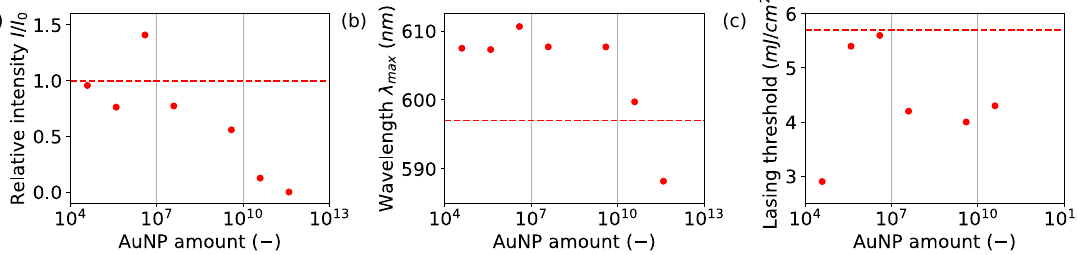
Figure 4. ( a ) relative maximum intensity of random lasing; ( b ) maximum wavelength of lasing emission and ( c ) change in lasing threshold as a function of AuNP amount in the dye doped PVA matrix.